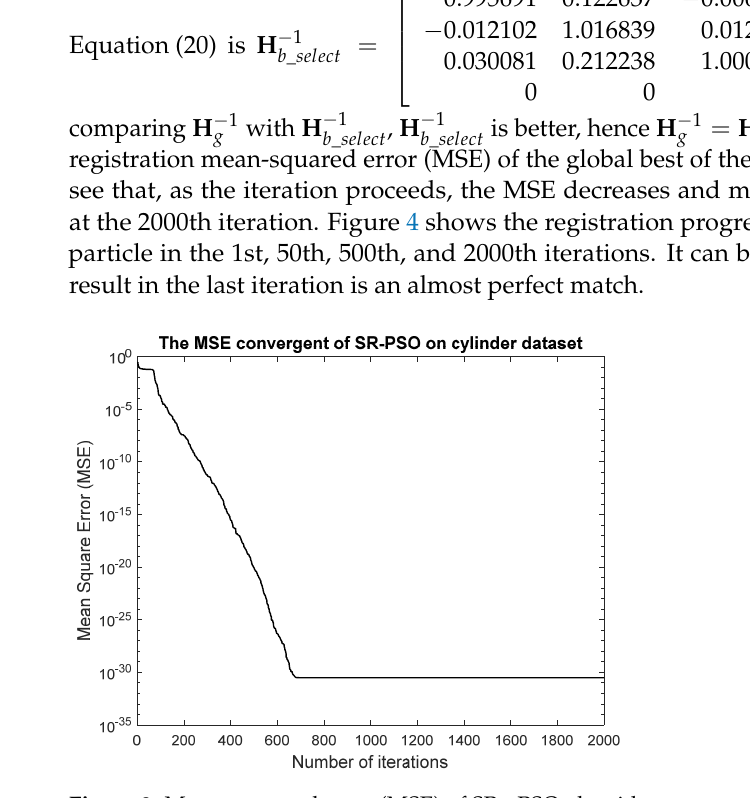
Figure 3. Mean − squared error (MSE) of SR − PSO algorithm.